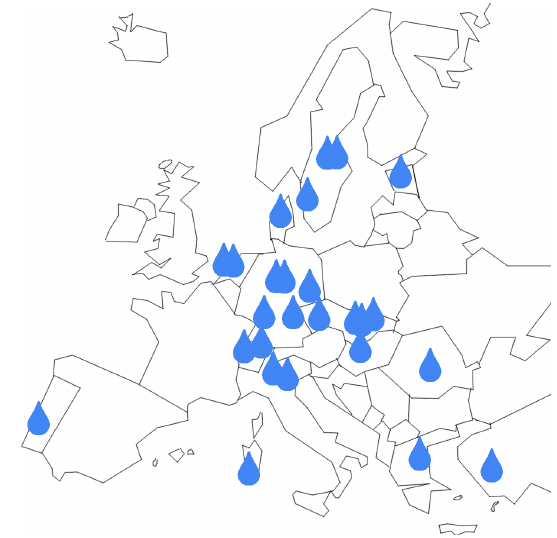
Figure 1. Schematized map of Europe where respondents to the survey are indicated as water